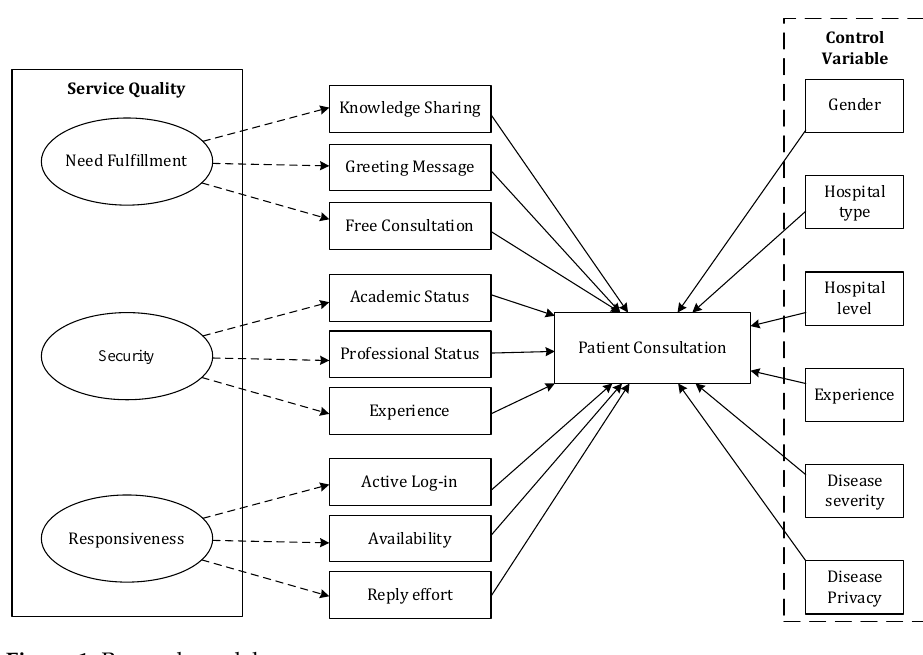
Figure 1. Research model.